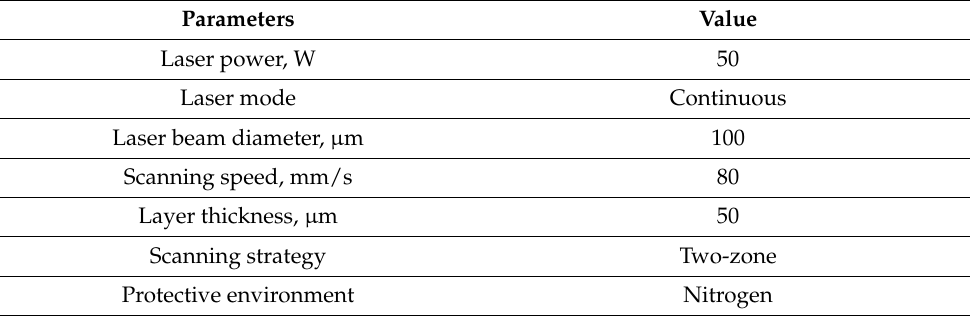
Table 3. LB-PBF process mode for the manufacture of products from steel 12X18H10T.